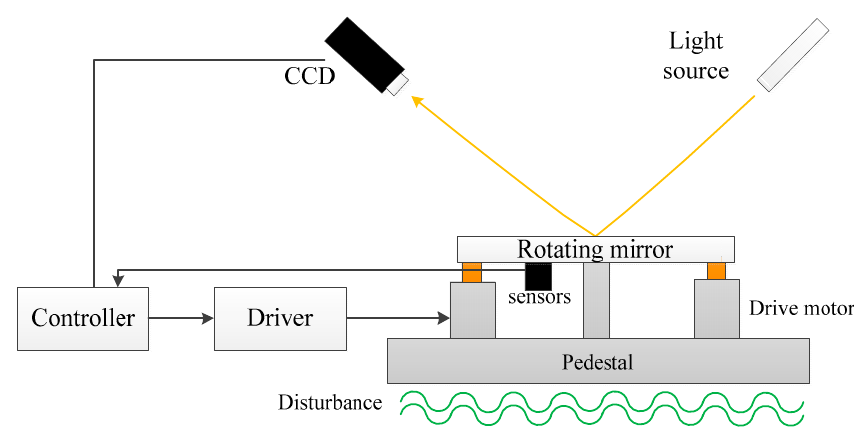
Figure 1. The configuration of the FTOS.